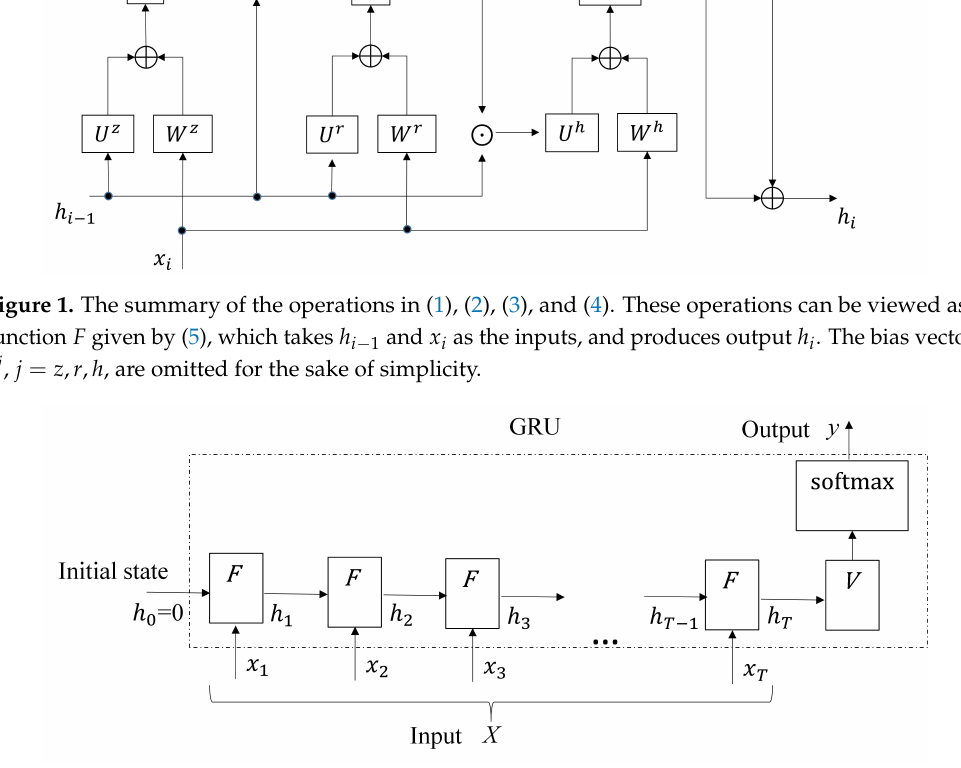
Figure 2. The complete gated recurrent unit (GRU) operations. There are T iterations for the input sequence X , where each iteration is represented by the function F . The output y of the GRU is then obtained from the result of the final iteration T by